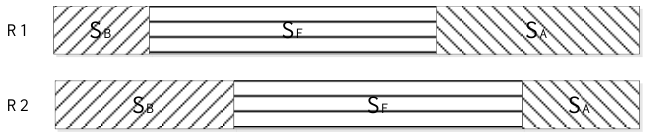
Figure 2. Criteria of R 1 performs better than R 2 in theoretical study (e.g.,